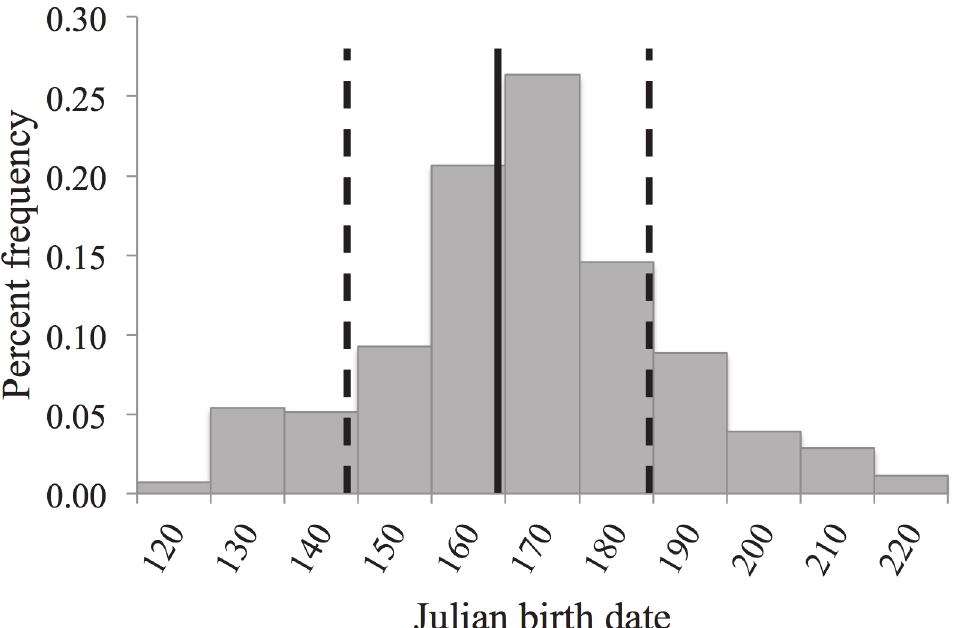
Fig 2. Percent frequency of Julian birth dates for litters ( n = 1,403) of captive white-tailed deer at Kerr Wildlife Management Area, Kerr County, Texas, USA from 1977 – 2012. The vertical, solid line represents the mean Julian birth date (164, 13 June) and the vertical, dashed lines represent the standard deviation (144 and 185, 24 May and 4 July, respectively).